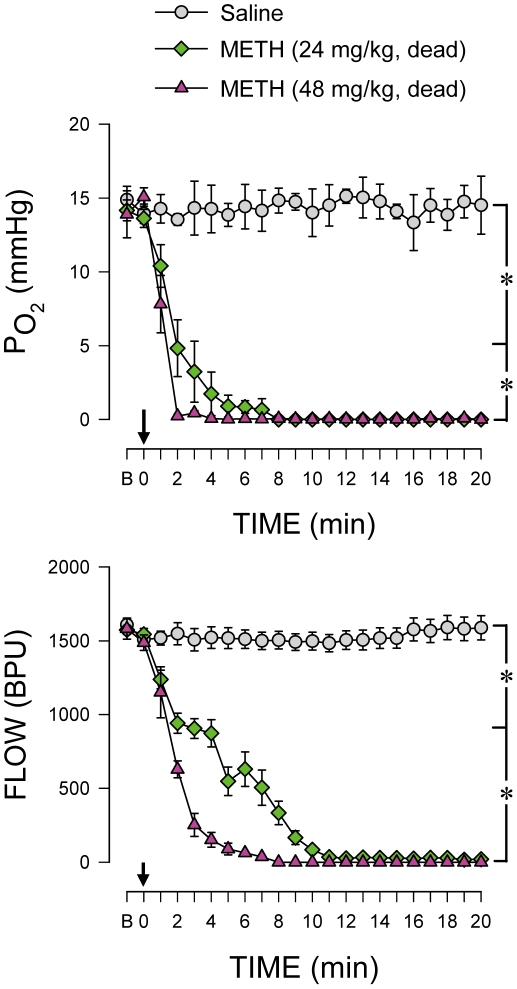
Methamphetamine dose-dependently and time-dependently elicited anoxia and cessation of microperfusion in rostral ventrolateral medulla.Temporal changes in tissue partial pressure of oxygen and blood flow detected in rostral ventrolateral medulla (RVLM) of animals that died of intravenous administration of METH (at arrow). Values are mean ± SEM, n = 5–9 animals per experimental group. *P<0.05 versus saline group at corresponding time-points in the post hoc Scheffé multiple-range test. B, baseline.